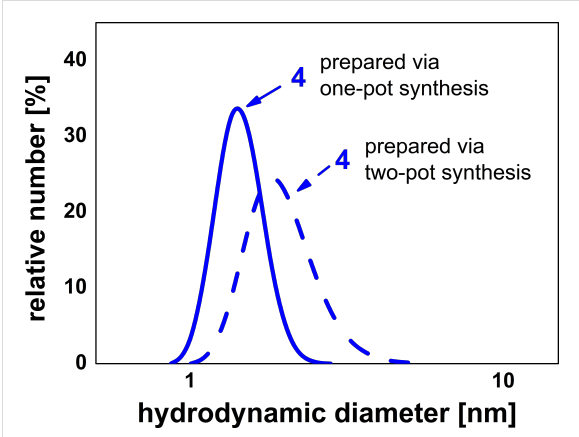
Figure 4: Number-average hydrodynamic diameters of compound 4 prepared via the one-pot (continuous line) and the two-pot (dashed line)